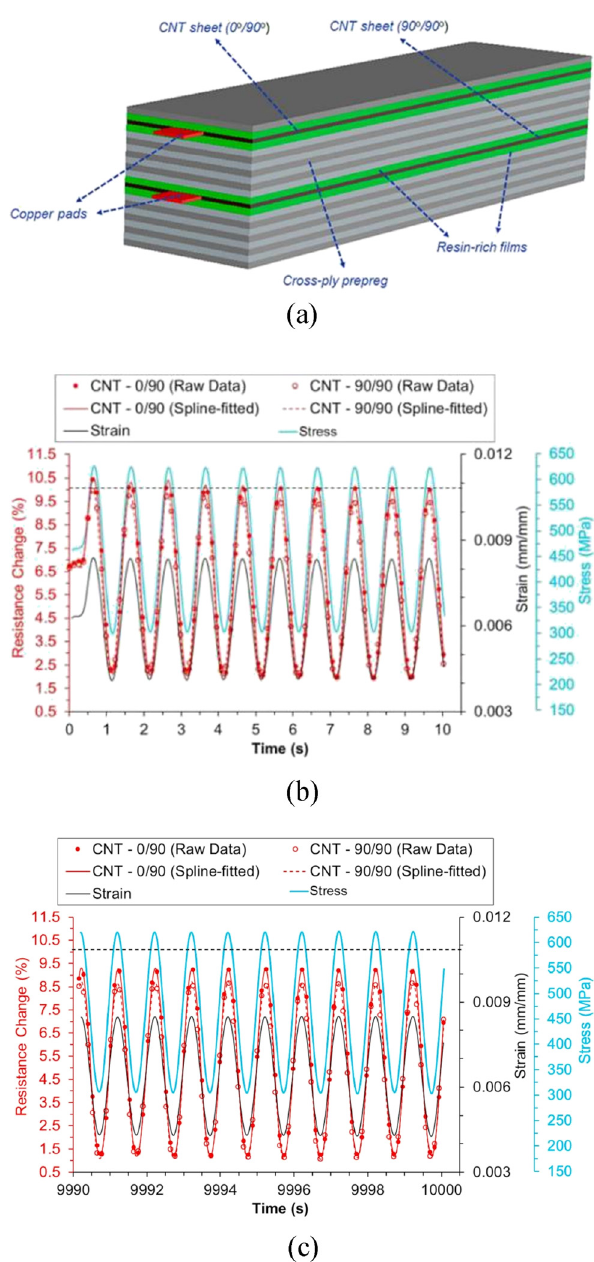
Figure 25: ( a ) Lay - up sequence of the CNT sheet integrated in a cross - ply carbon - epoxy laminate for fatigue test; ( b ) and ( c ) real - time electrical and mechanical response under cyclic fatigue loading of the carbon fi ber laminates with integrated CNT sheets during fi rst ten cycles and last ten cycles of the fatigue testing ( dashed line showing the initial peak magnitude of the electrical resistance ) [ 157 ]